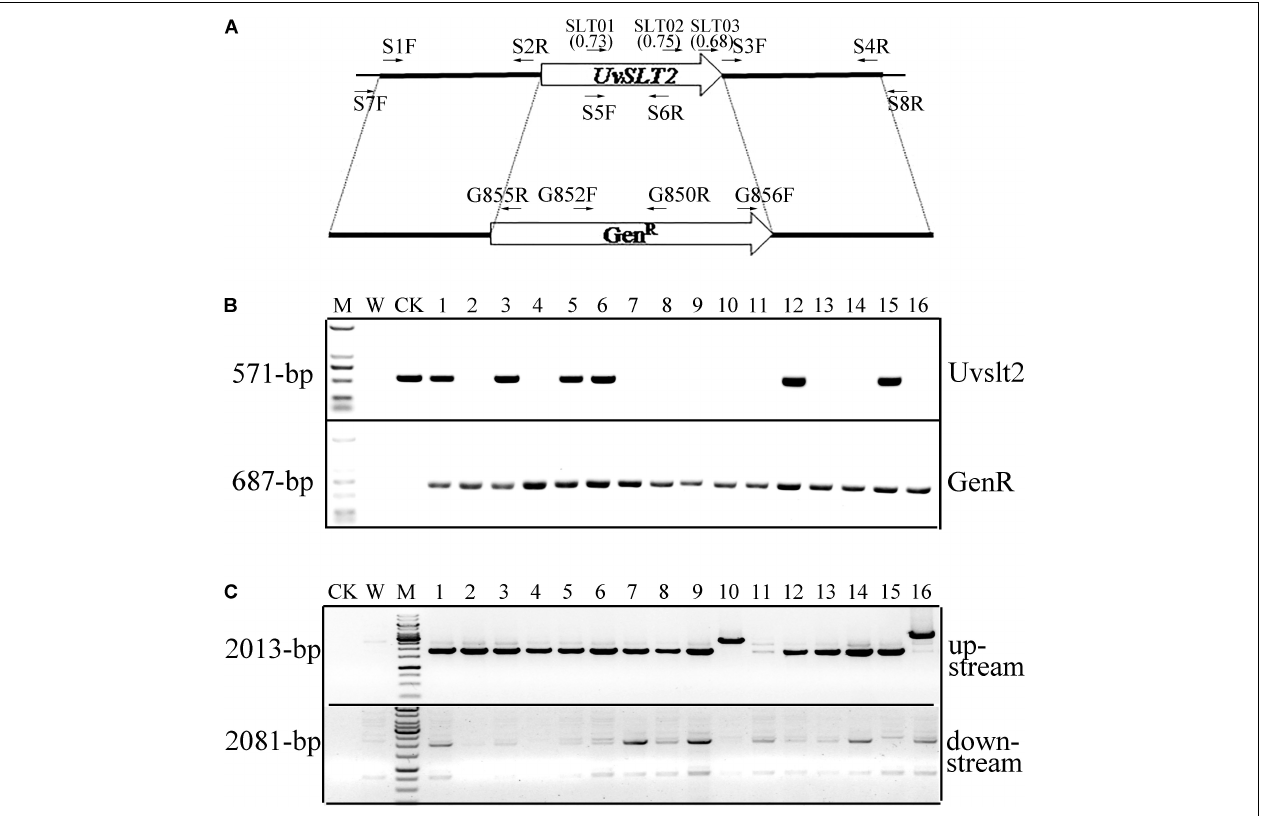
FIGURE 4 | The UvSTL2 gene and deletion mutants. (A) The UvSLT2 gene and gRNA spacers. The position and direction of gRNA spacers and primers used to generate and screen Uvslt2 deletion mutants are marked with arrows. The on-target scores of spacers SLT01, SLT02, and SLT03 are labeled in the bracket. (B) PCR assays for the deletion of UvSTL2 (upper panel) and presence of the geneticin-resistance gene (lower panel) in 16 transformants generated with pCas9-tRp-gRNA-SLT01 (spacer SLT01). The 571-bp UvSTL2 fragment was only amplified in the wild-type (CK) and transformant 1, 3, 5, 6, 12, and 15. M: 1-kb DNA ladder marker. (C) PCR assays to verify gene replacement events in 16 putative Uvslt2 deletion mutants. The 2013-bp upstream and 2081-bp downstream recombination products were amplified with primer pairs SLT27F(S7F)/G855R and SLT8R(S8R)/G856F, respectively. Amplification with P1 was used as the negative control. M: 1-kb DNA ladder marker.